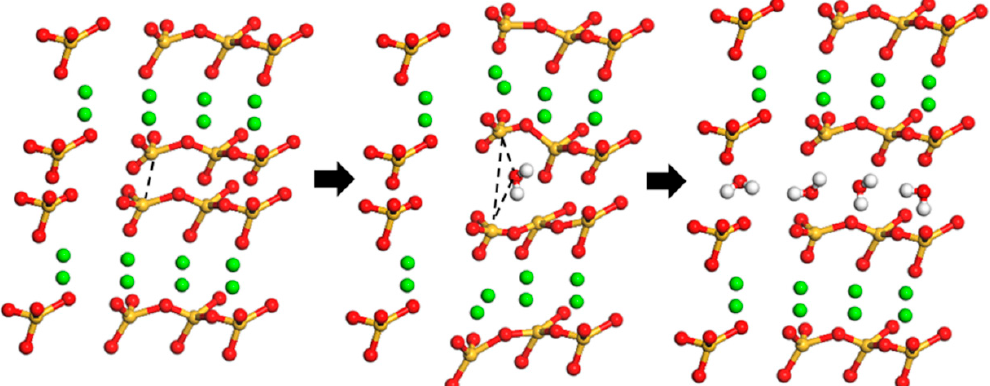
Figure 5. Diagram of interlayer interaction after water molecules entering C–S–H structure. Yellow ball, green ball, red ball connected with yellow ball, red ball connected with white ball and white ball represent the silicon atom (Si), layered calcium atom (Ca), oxygen atom (O) in the silicate chain, oxygen atom (Ow) in water and hydrogen atom (Hw) in water respectively.